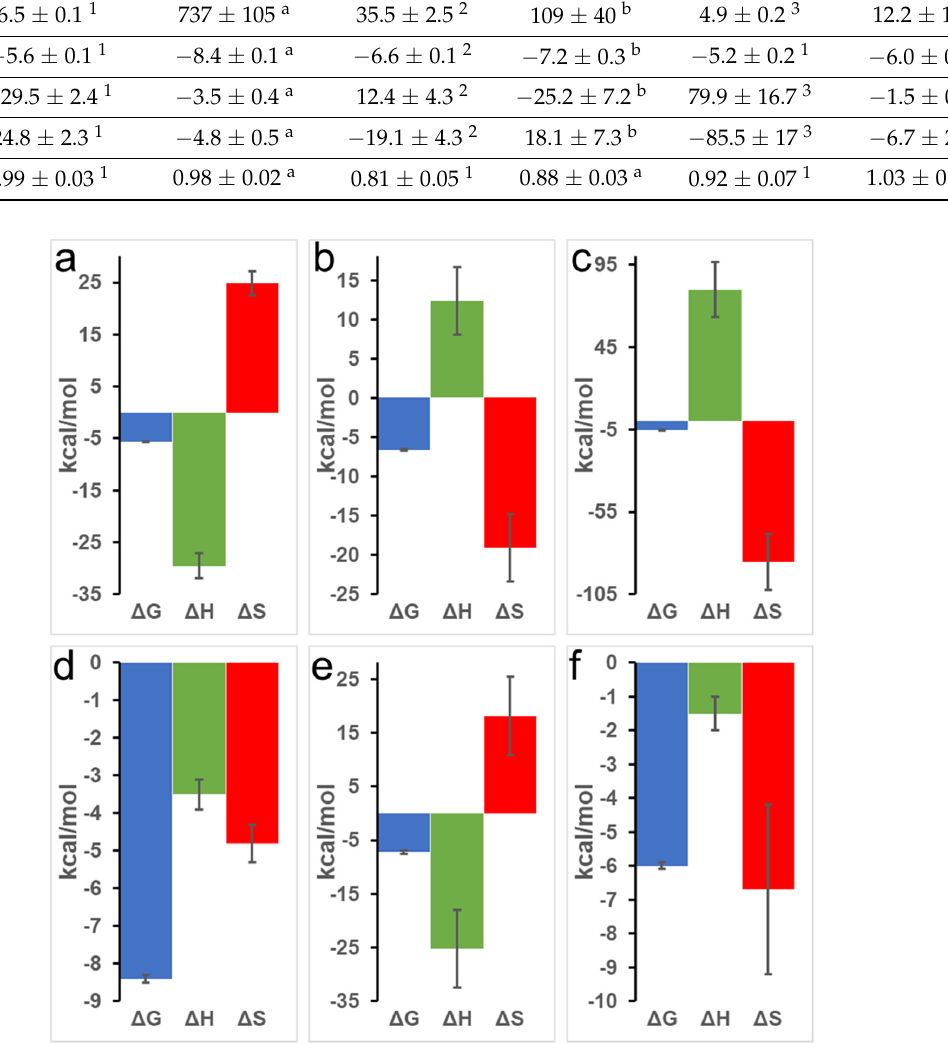
Figure 2. Representative signature plots of binding of PYR with equine Mb. Top row ( a – c ) displays PYR interaction with oxy-Mb at ( a ) pH 7.0, ( b ) pH 6.4, and (c ) pH 6.0. Bottom row ( d – f ) displays PYR interaction with deoxy-Mb at ( d ) pH 7.0, ( e ) pH 6.4, and ( f ) pH 6.0. All the ITC experiments were repeated 3 times ( n = 3) to obtain the thermodynamic properties. Statistical analysis was performed using one-way ANOVA.